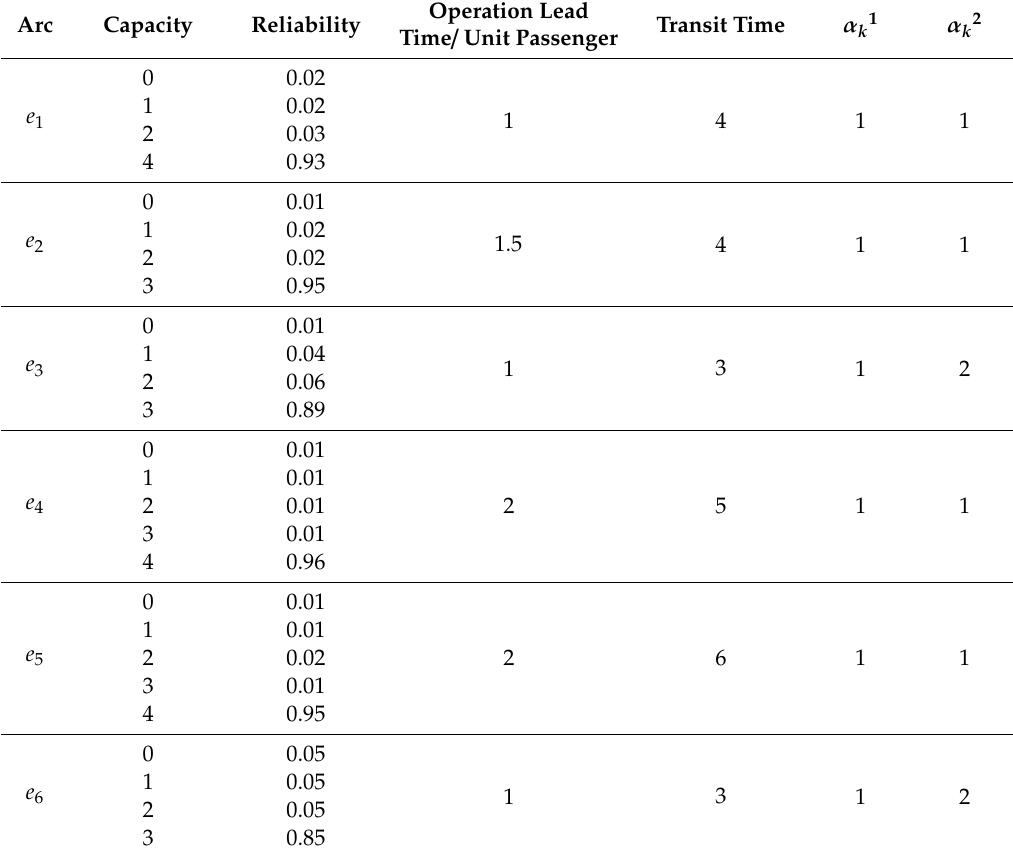
Table 16. Basic information of each